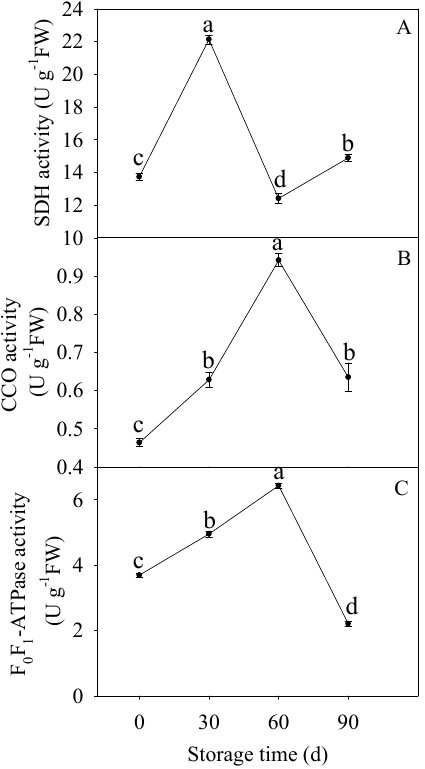
Figure 2. Changes in succinic dehydrogenase (SDH) ( A ), cytochrome c oxidase (CCO) ( B ), and F 0 F 1 - ATPase ( C ) activities in postharvest pumelos during storage at 25 °C. Each data point was shown as the mean ± standard error (SE). Different letters indicated significant difference ( p < 0.05).